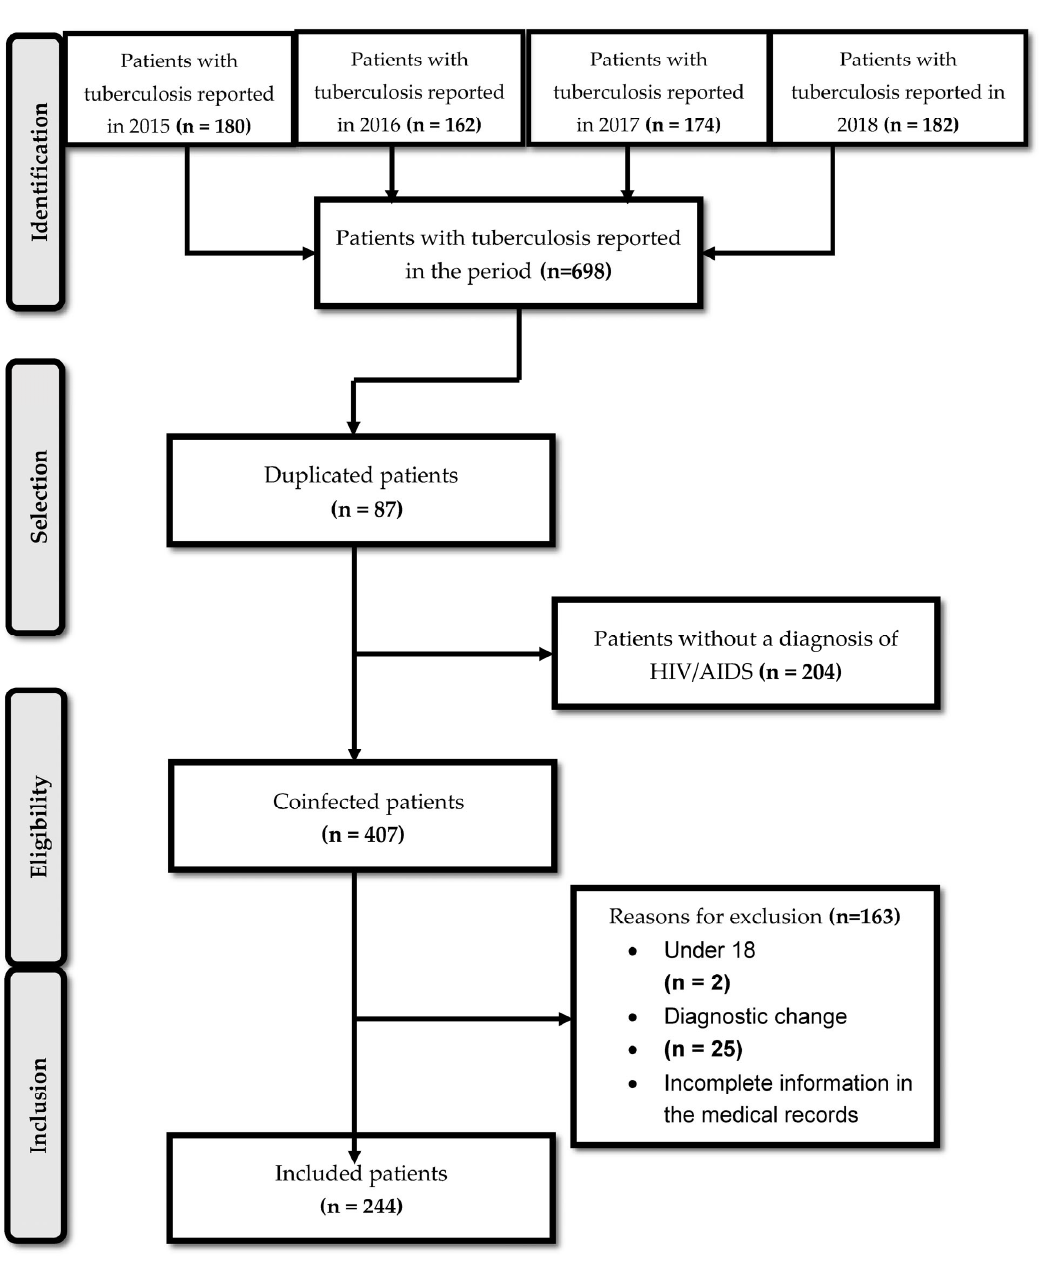
Figure 1. Inclusion and exclusion diagram of cohort patients.